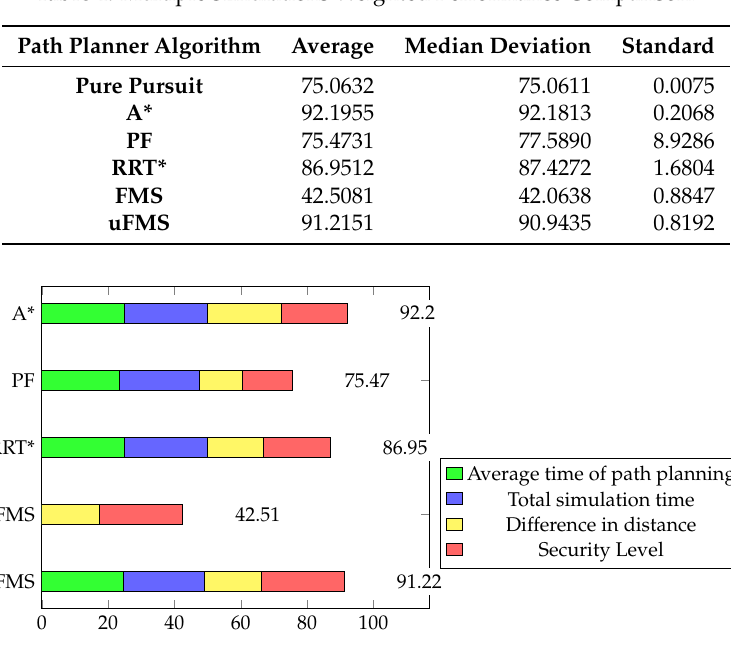
Figure 13. Performance metrics of the path planning techniques.